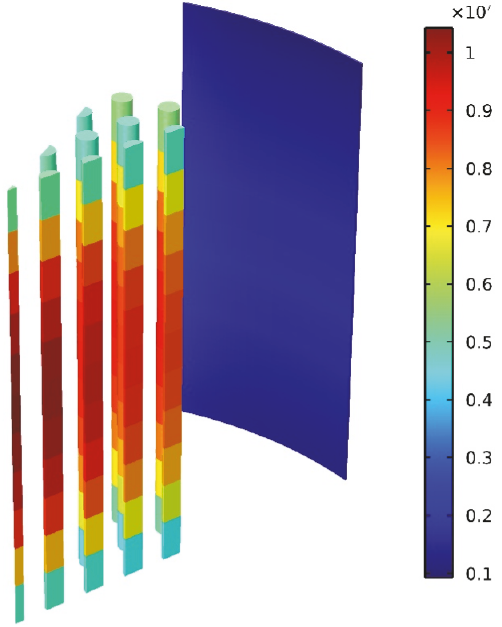
Figure 6: Power density distribution in fuel salt (unit: